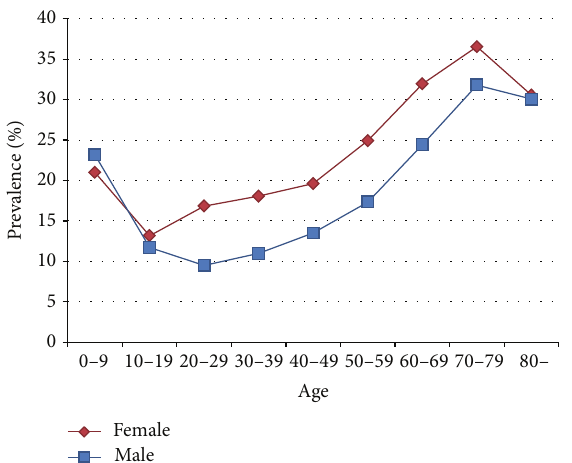
Figure 1: Age-sex distribution of patients with visits to different healthcare facilities within one day in the 1,000,000-person cohort in